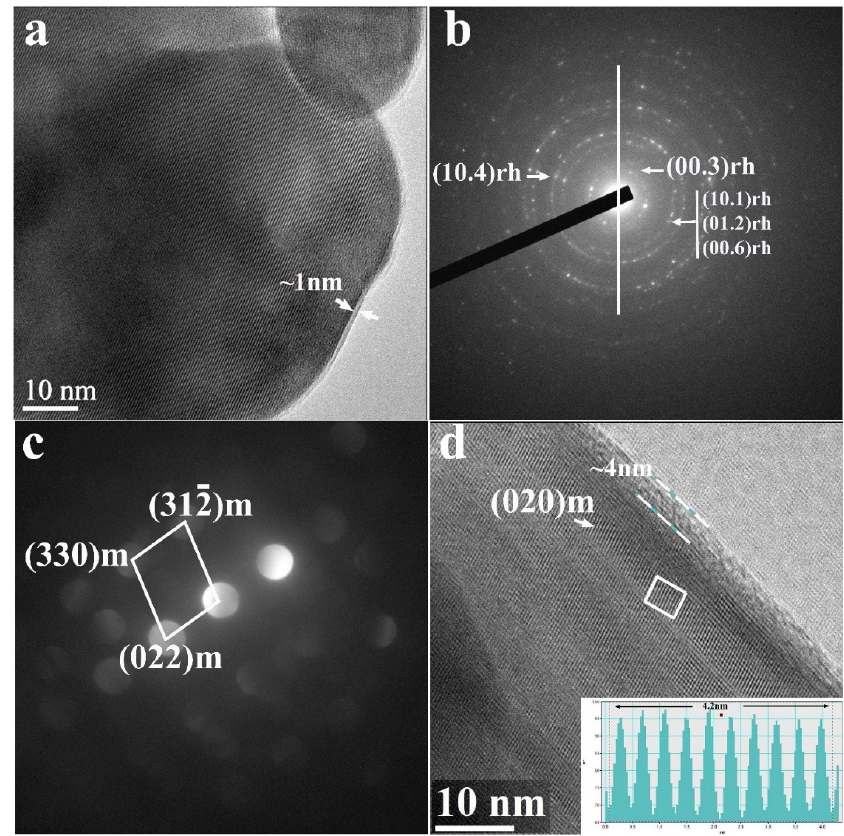
Figure 4. ( a ) TEM bright-field image of HE-NCM sample treated with 5 wt.% of Li 2 SO 4 , as indicated in Section 2. It shows a thin homogenous layer of around 1–4 nm thickness (marked with white arrows) composed of Li 2 SO 4 monoclinic phase (as follows from XRD data in Figure 1). ( b ) SAED shows a diffraction pattern matching the Li(TM)O 2 rhombohedral R-3m (166) phase. ( c ) CBED pattern matches with the constituent Li 2 MnO 3 monoclinic C2/m (12) phase. ( d ) HRTEM image presenting the characteristic lattice fringes for the Li 2 MnO 3 monoclinic C2/m (12) phase. The insert presents a line of ”ten” d -spacing measuring 4.2 nm [d 020 = 4.2 Å] and assigned to the (020) planes of Li 2 MnO 3.